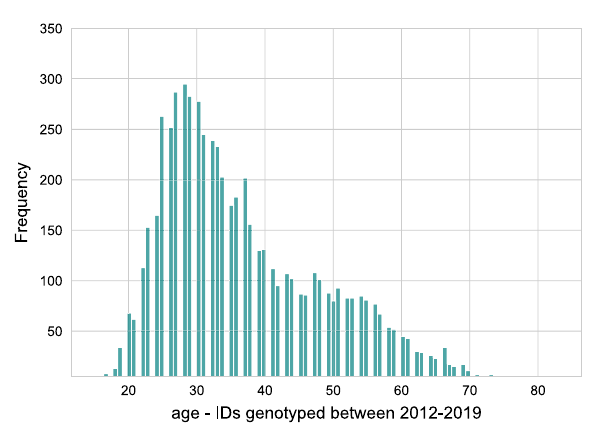
Figure 1. Metadata—age distribution of people with diagnosed HIV